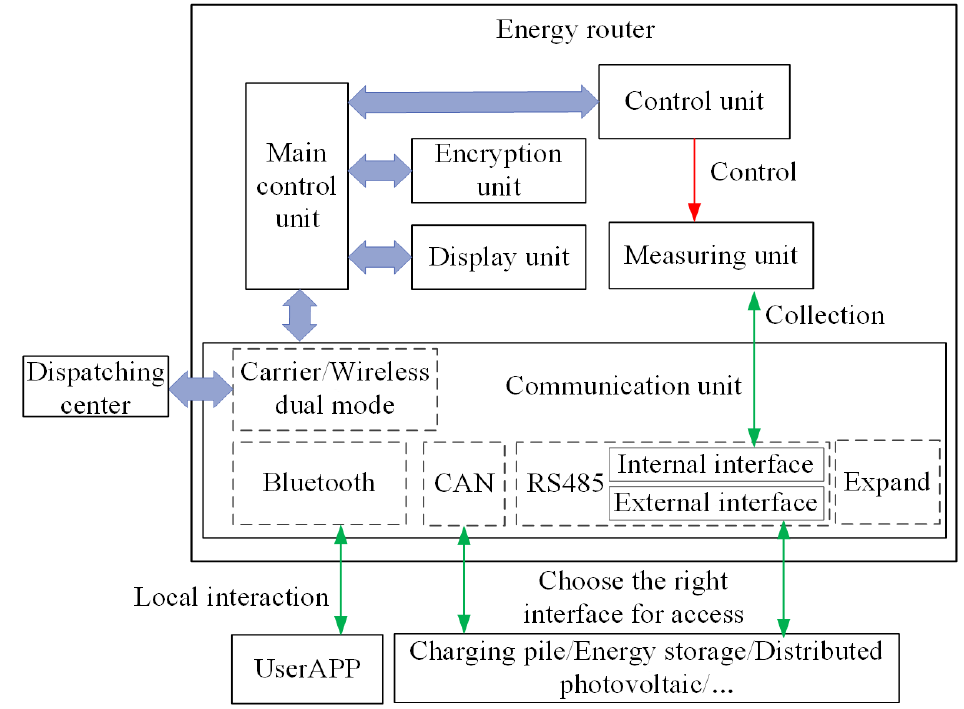
Figure 2. Function structure of the energy router.